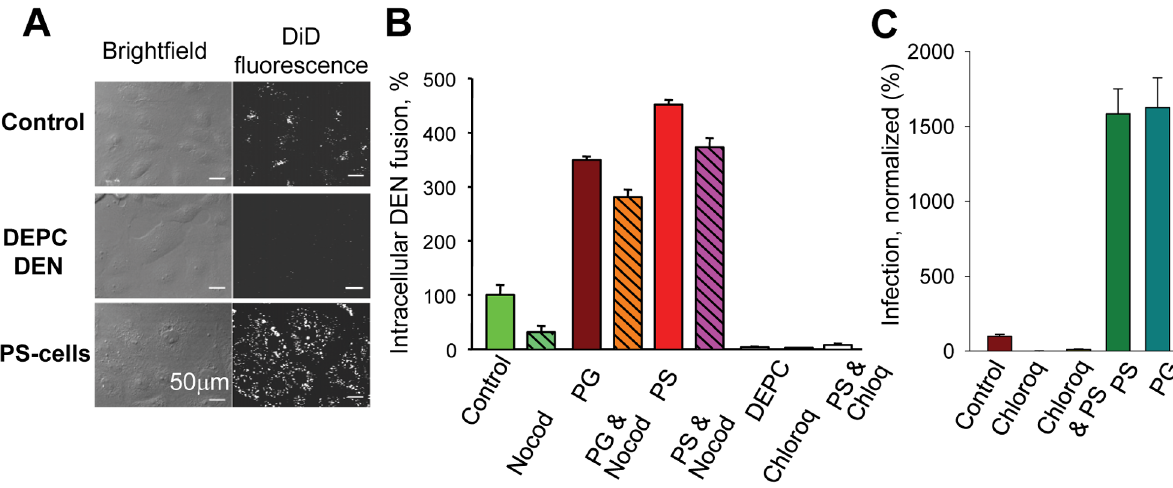
Figure 4. Anionic lipids promote DEN-mediated intracellular fusion and viral infection. A. An increase in the cell fluorescence upon fusion of DiD-labeled DEN within the endocytic pathway of MA104 cells. Images were taken 40 min after raising the temperature to allow internalization of the virus for PS-treated cells (PS-cells), untreated cells (Control) and untreated cells with DEPC-inactivated DEN (DEPC DEN). B. Intracellular DEN fusion was quantified as the mean total fluorescence per imaging field for: untreated MA104 cells (control, taken as 100%); cells pre-treated with either nocodazole (Nocod) or chloroquine (Chloroq); cells with DEPC-inactivated virus (DEPC); cells treated with PG (PG), cells pretreated with nocodazole and then treated with PG (PG&Nocod); cells treated with PS (PS), cells pretreated with chloroquine or nocodazole and then PS (PS & Chloroq and PS&Nocod). C. Promotion of DEN infection for MA104 cells treated with PS (PS) or PG (PG). Control – no exogenous lipids, taken as 100%. DEN infection of the cells treated or not treated with PS is inhibited by chloroquine (Chloroq & PS and Chloroq, respectively). B , C. The data are presented as mean + / 2 s.d, n $ 3.